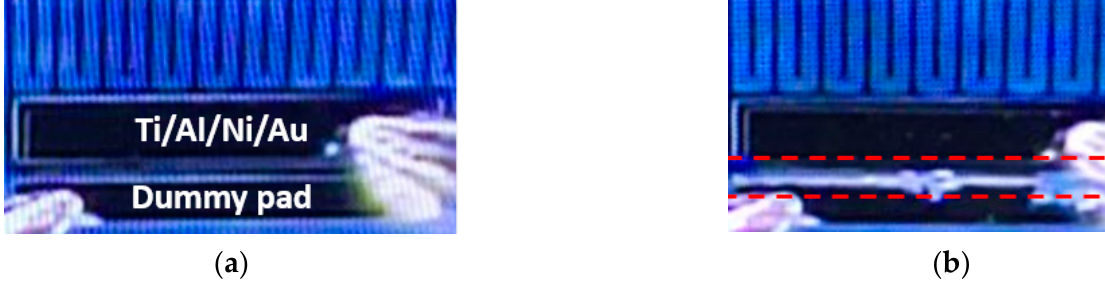
Table 2. Important parameters for the MSM AlGaN UV sensor.